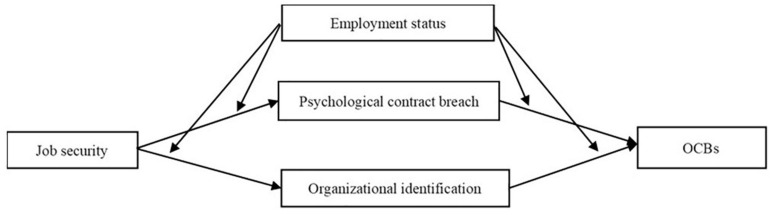
Conceptual model.